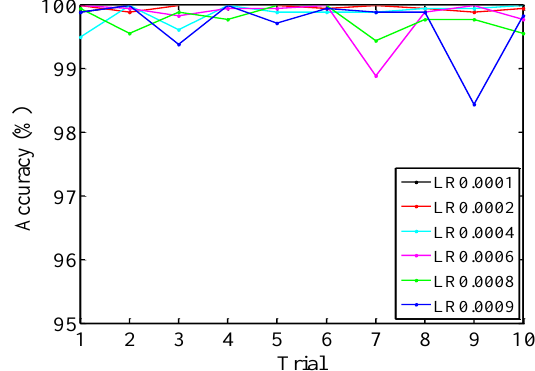
Figure 12. The accuracy in 10 trials.